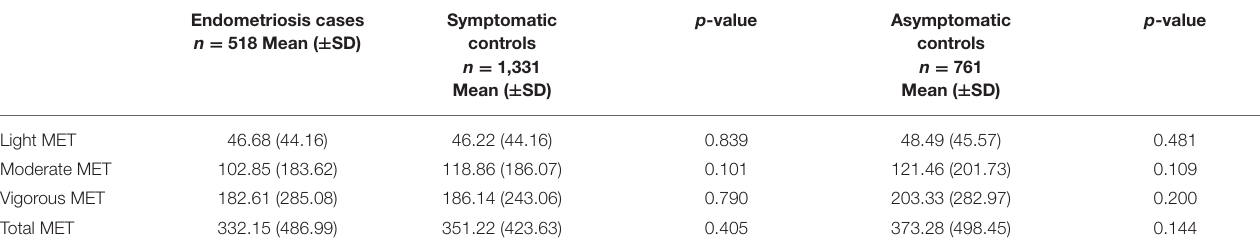
TABLE 7 | Physical activity, measured by MET-minutes/week, in women with endometriosis vs. symptomatic controls and asymptomatic controls. Endometriosis cases n = 518 Mean ( ±